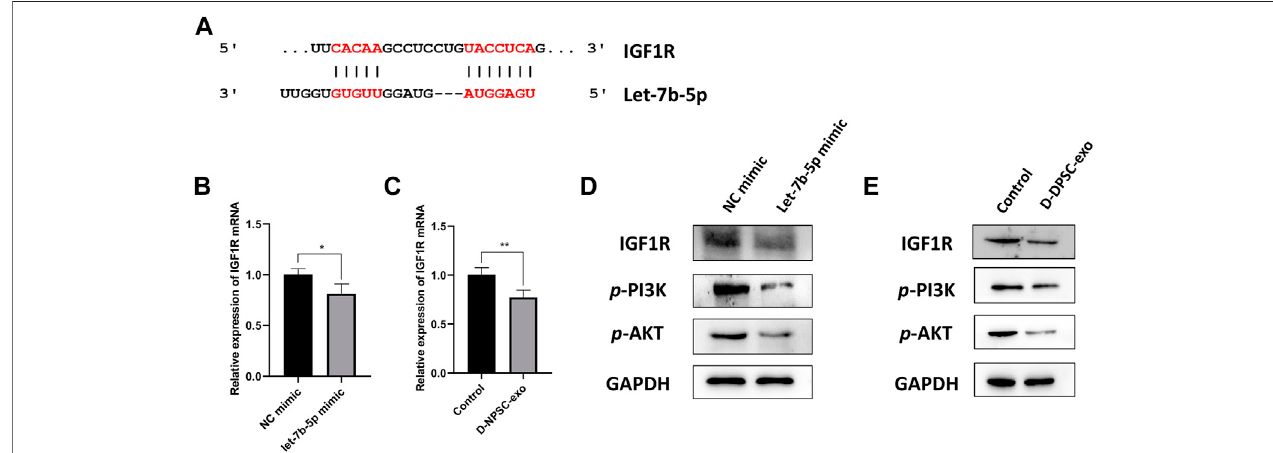
FIGURE6| D-NPSC-exoaggravatedcelldegenerationofAFCsbyinhibitingtheactivationoftheIGF1R/PI3K/Aktpathway. (A) Shownarelet-7b-5pbindingsitesin theIGF1R3 ′ UTRaspredicted inTargetScan. (B) mRNAexpressionlevelofIGF1RinAFCstransfectedwithlet-7b-5p mimicwasdetectedbyreal-timePCR. (C) mRNA expression level of IGF1R in AFCs treated with D-NPSC-exo was detected by real-time PCR. (D) Protein expression levels of IGF1R, p -PI3K, and p -AKT in AFCs transfectedwith let-7b-5p mimic weredetected byWestern blotting. (E) Proteinexpression levels ofIGF1R, p -PI3K, and p -AKT inAFCs treatedwithD-NPSC-exo were detected by Western blotting. * p < 0.05; ** p <